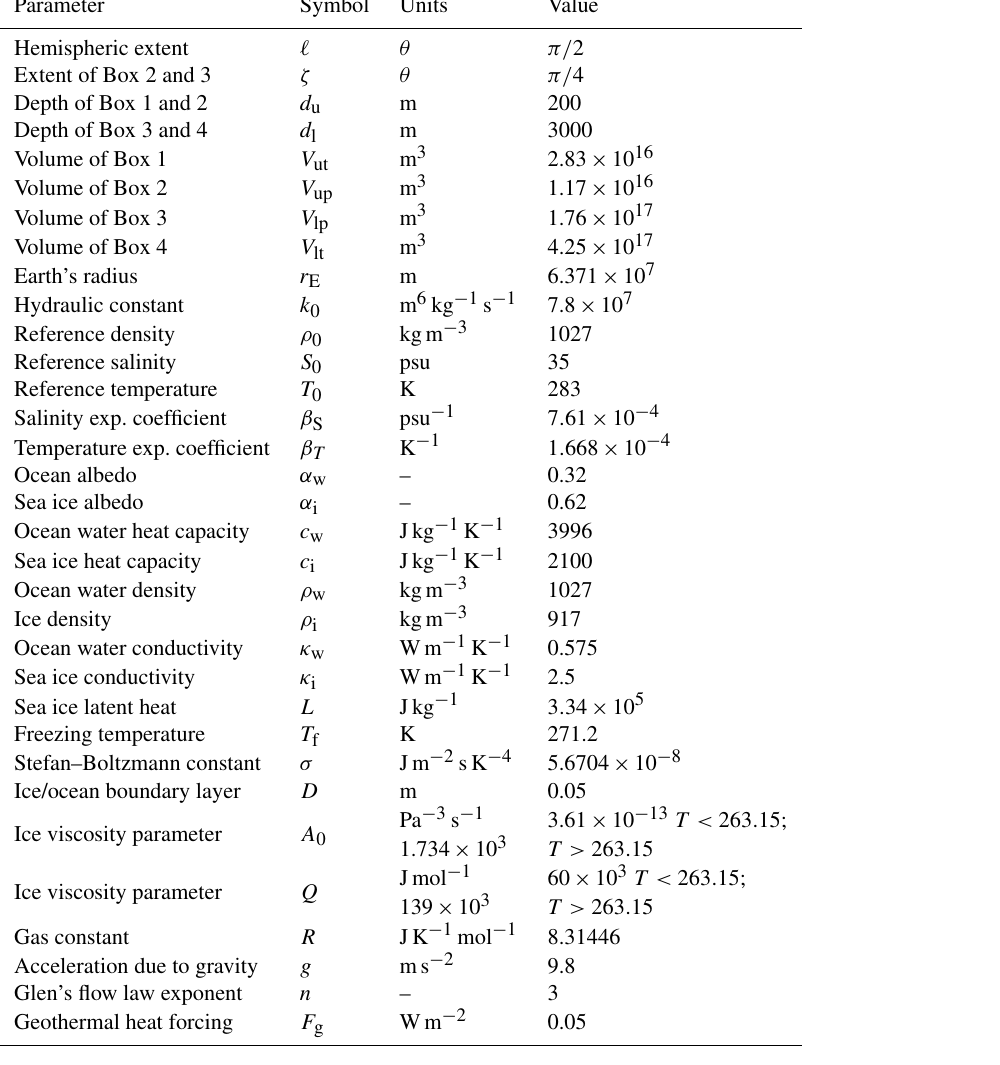
Table 2. Physical parameters used in simulations. See text for details on model initialization and settings of unconstrained parameters.